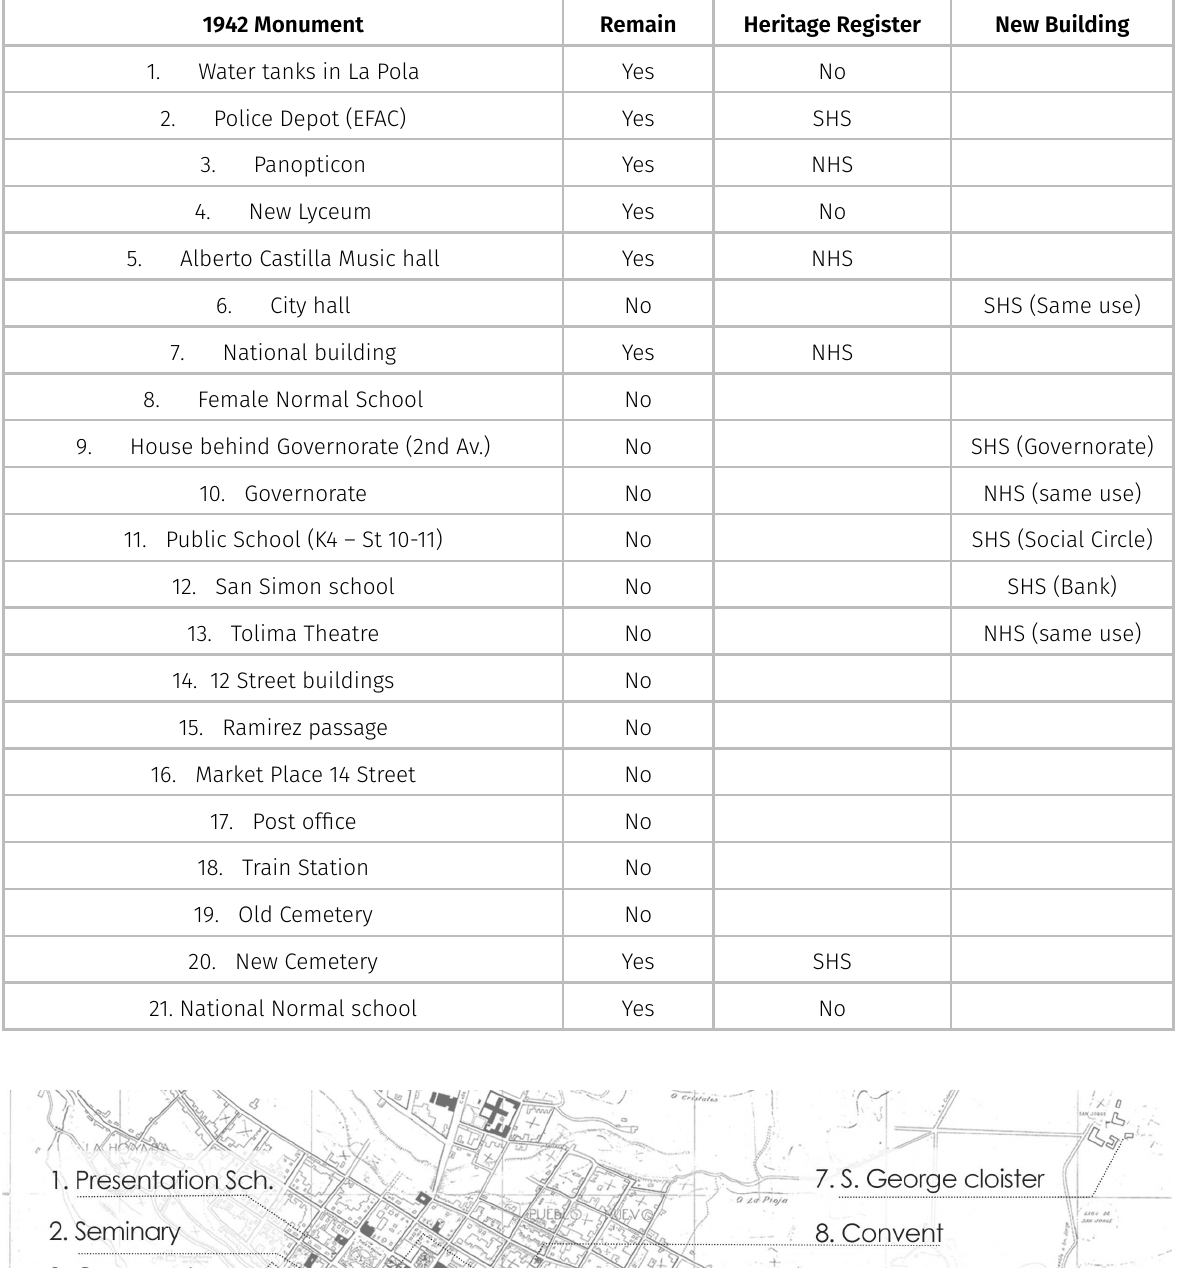
Table I. List of monuments in the Ibague map of 1942.